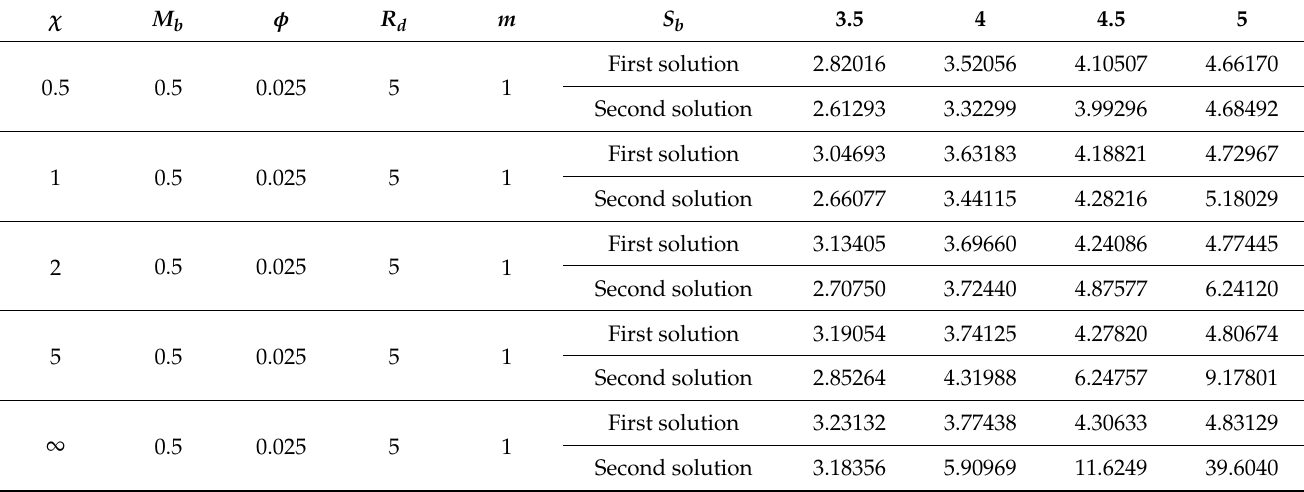
(cid:16) (cid:17) k nf / k f θ (cid:48) ( 0 ) for distinct values of S b , χ , φ , R d , m , and M b